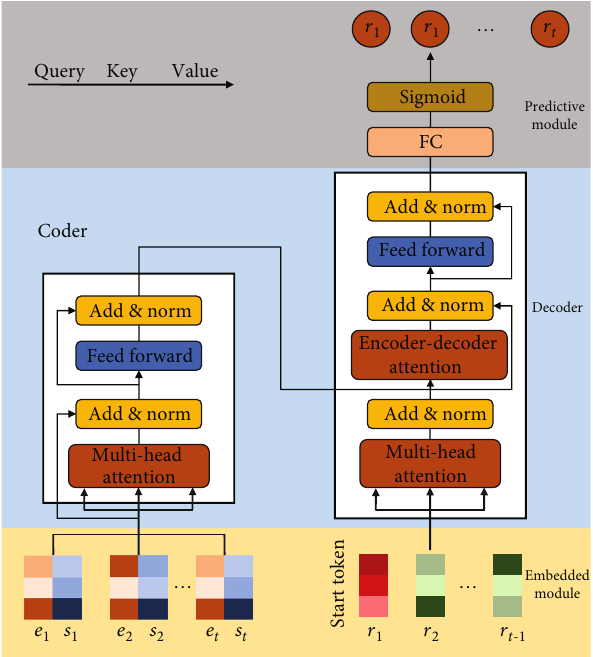
Figure 3: GTRKT model structure